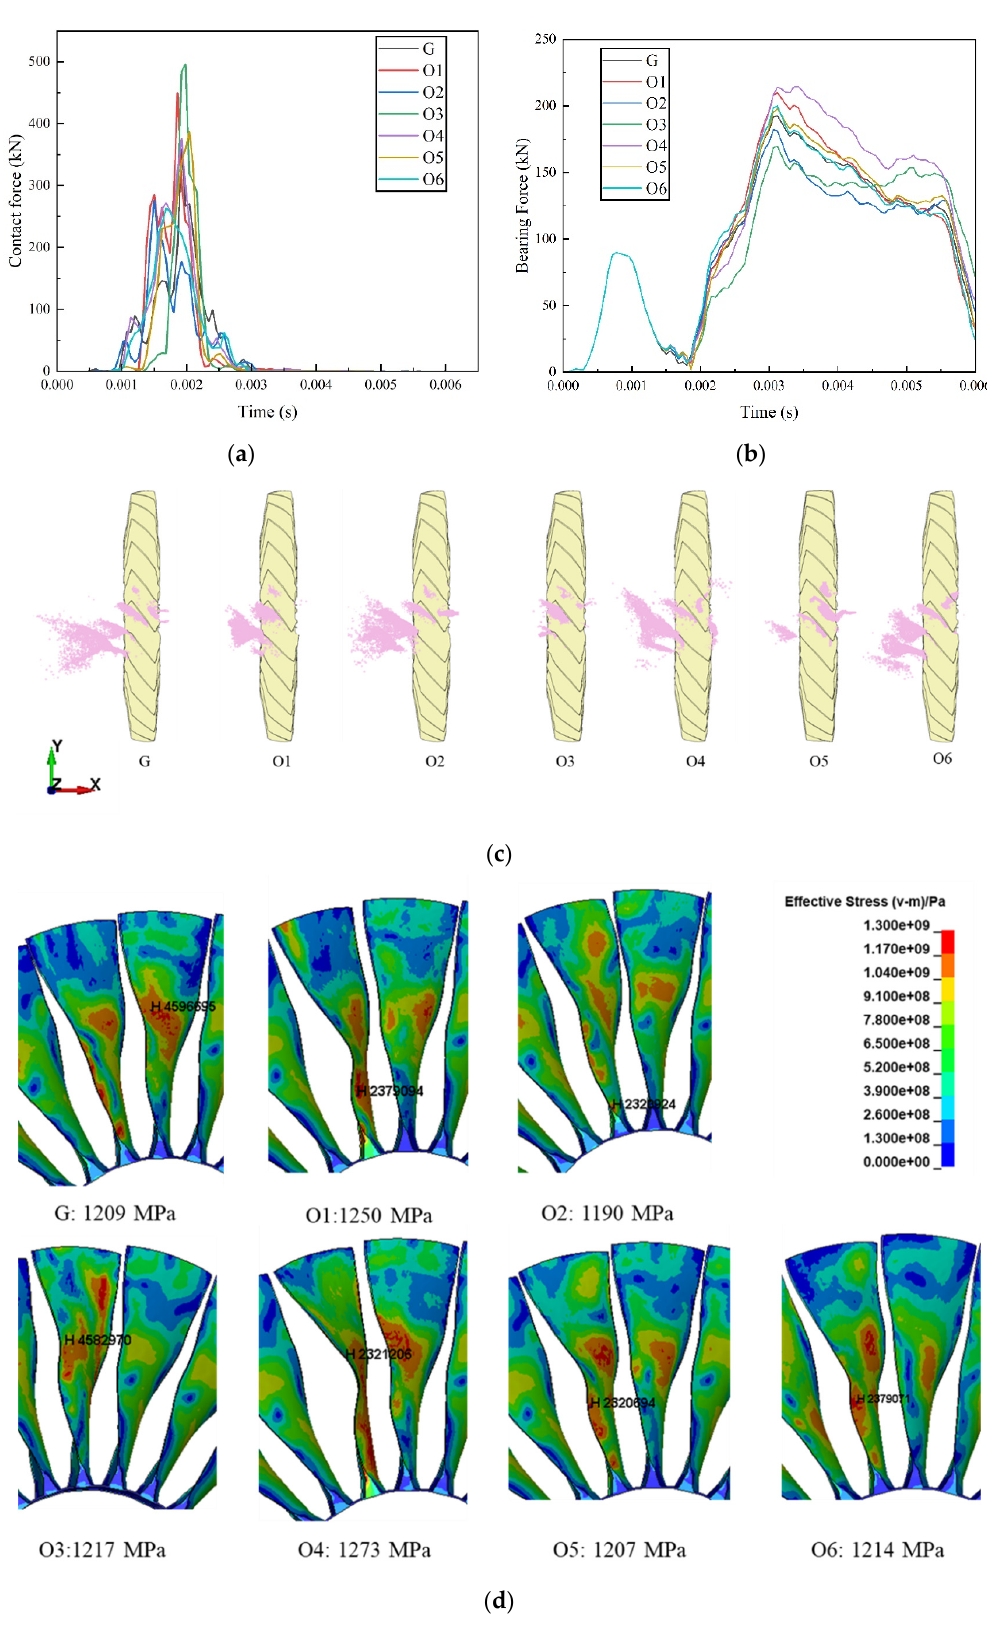
Figure 9. Simulation results of different impact orientations: ( a ) contact force vs. time; ( b ) bearing force vs. time; ( c ) bird deformations at t = 2.04 ms; and ( d ) von Mises stress at t = 2.04 ms.